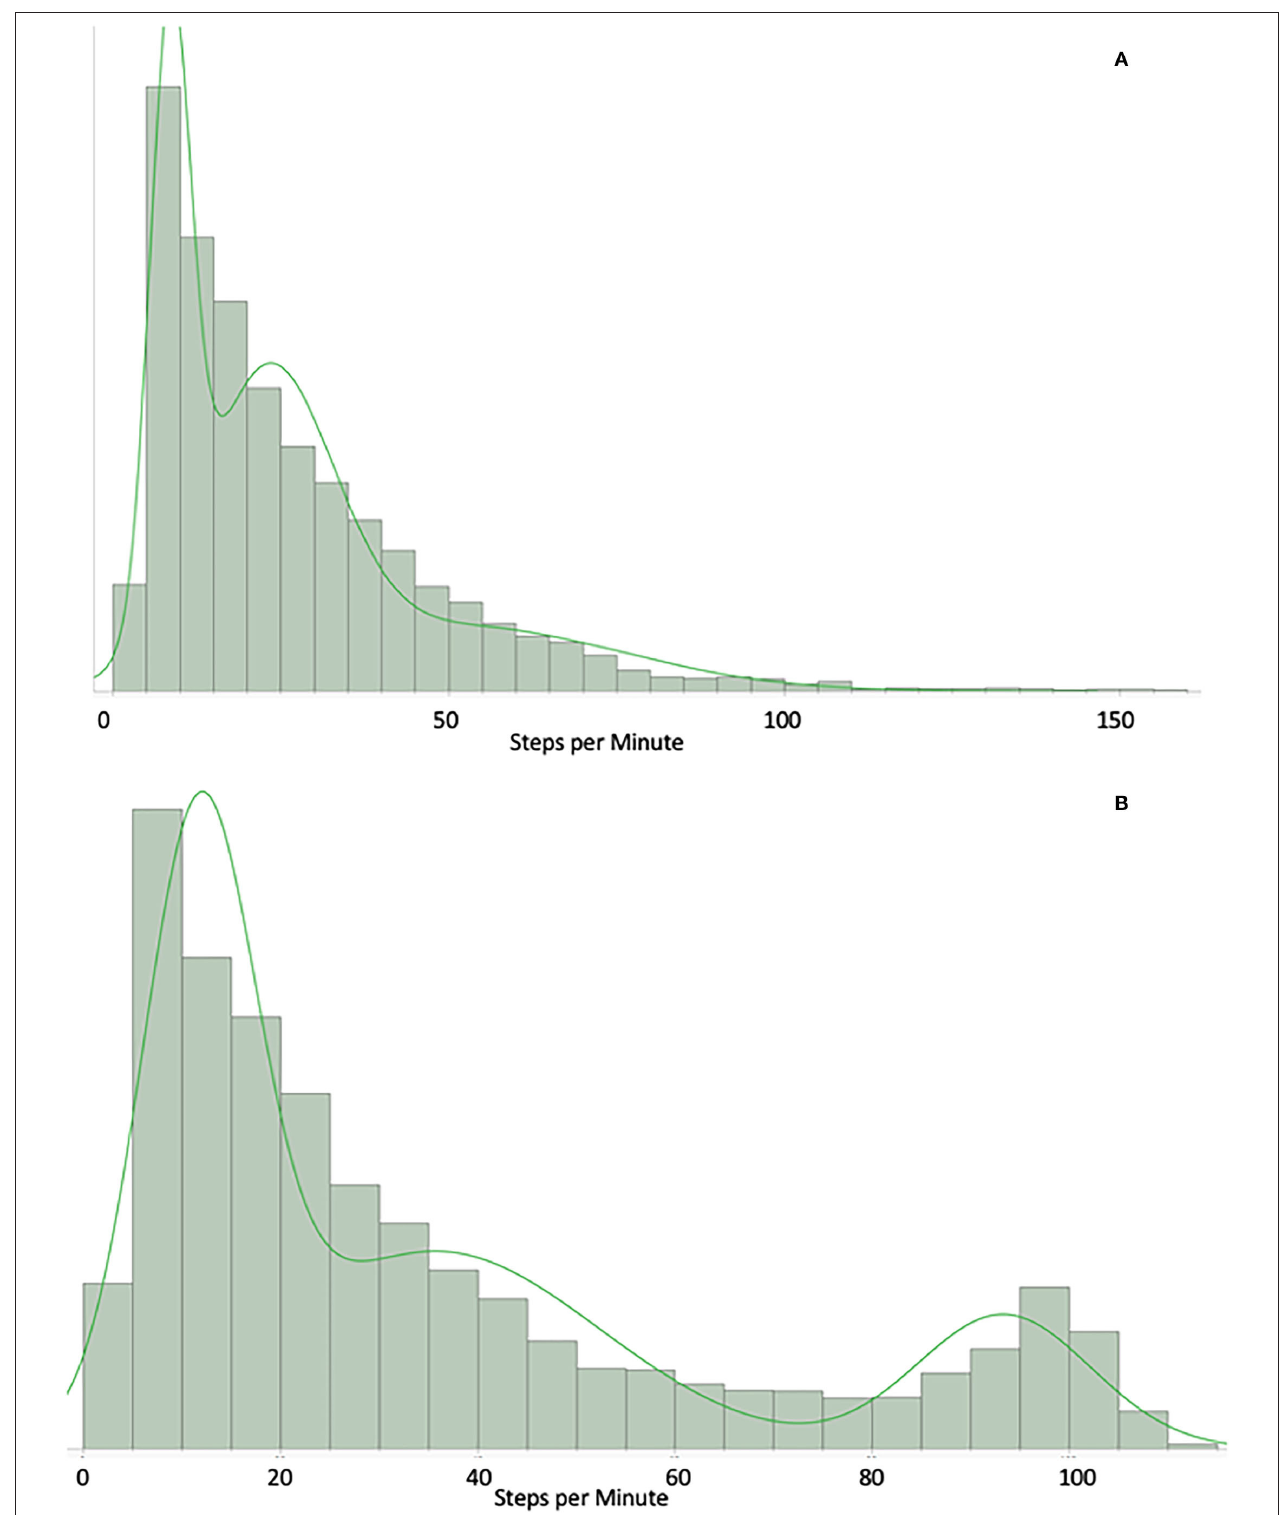
FIGURE 2 | (A) Example of a participant who spends most of the time in low levels of physical activity. GMM: X axis = count of steps per minute over 1 month. Example of a participant who spend most of their time in low levels of physical activity (10–30 steps/min). (B) Example of a participant who performs some higher physical activity. GMM: X axis = count of steps per minute over 1 month. Example of a participant who do some level of higher physical activity (bump around the 100–130 steps/min).